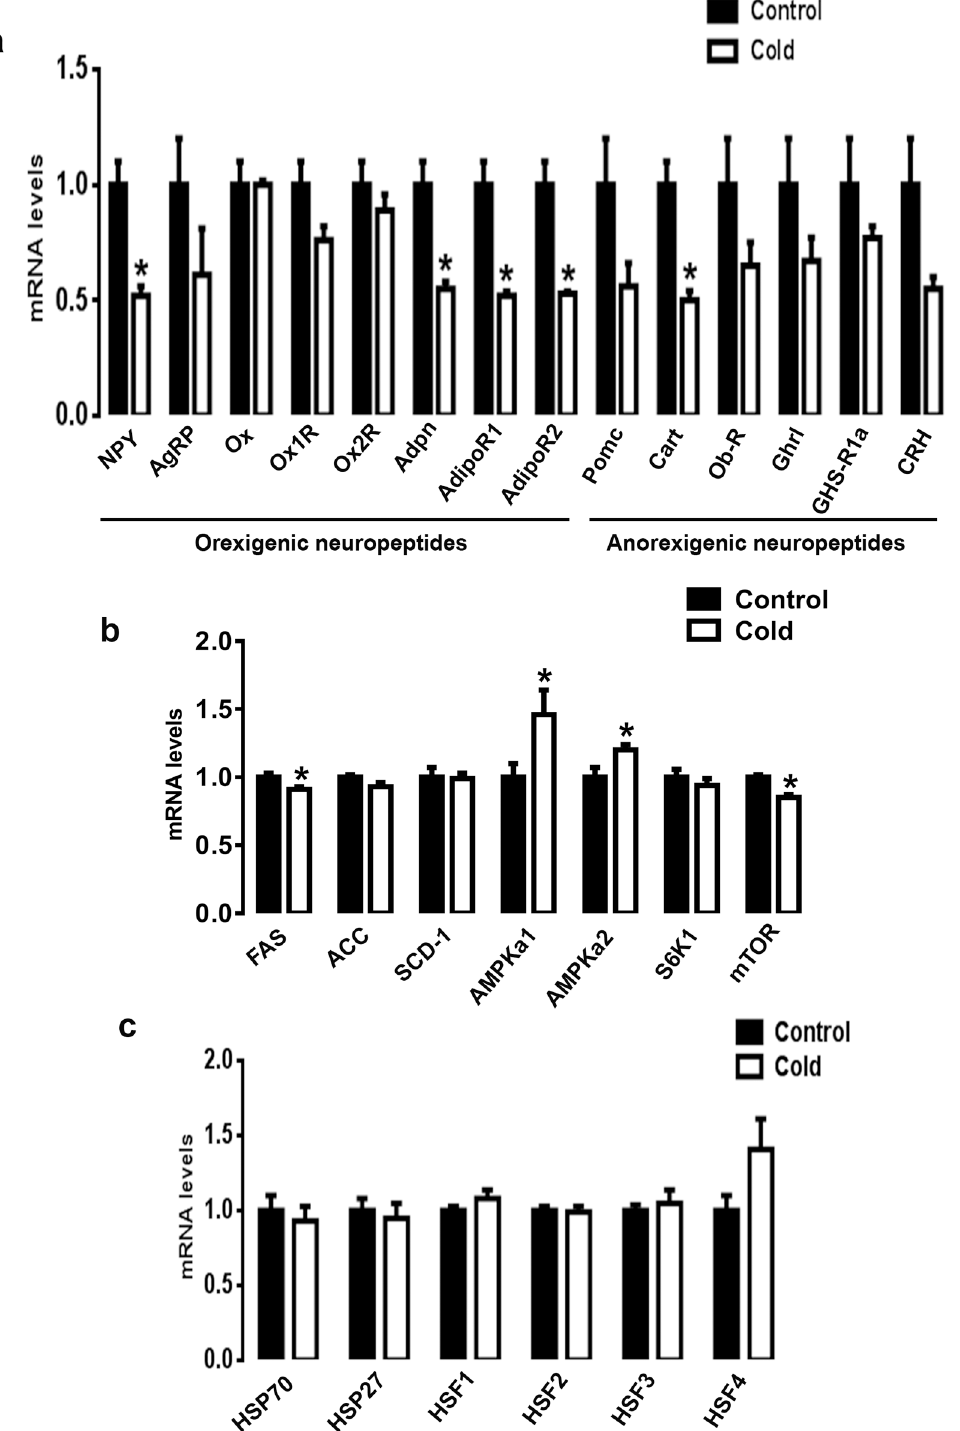
Fig 3. Effect of CMCC on feeding-related genes and HSPs in the brain of young broiler chicks. Relative expression of hypothalamic feeding-related neuropeptides (a), lipogenic genes (b), HSPs and HSF (c) were determined by qPCR using 2 - ΔΔ Ct method [25]. Data are presented as mean ± SEM (n = 6). * Indicate a significant difference between cold and control group ( P <